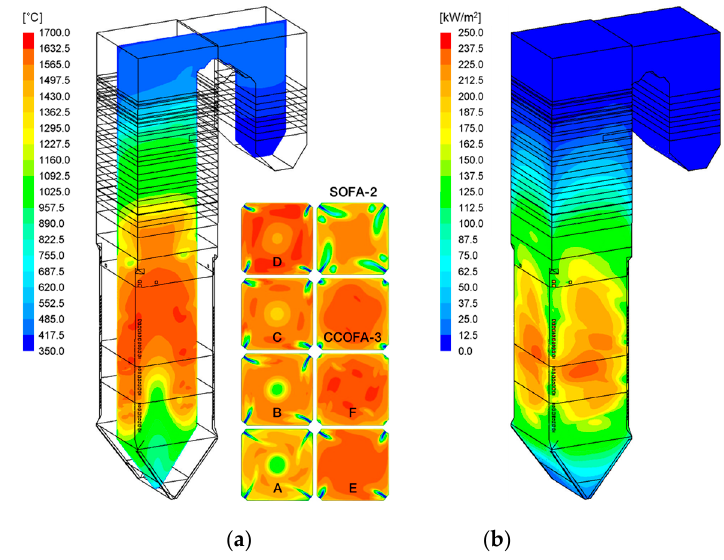
Figure 3. Temperature and wall heat flux for the reference case (C05-S20). ( a ) Temperature and ( b ) Wall heat flux.